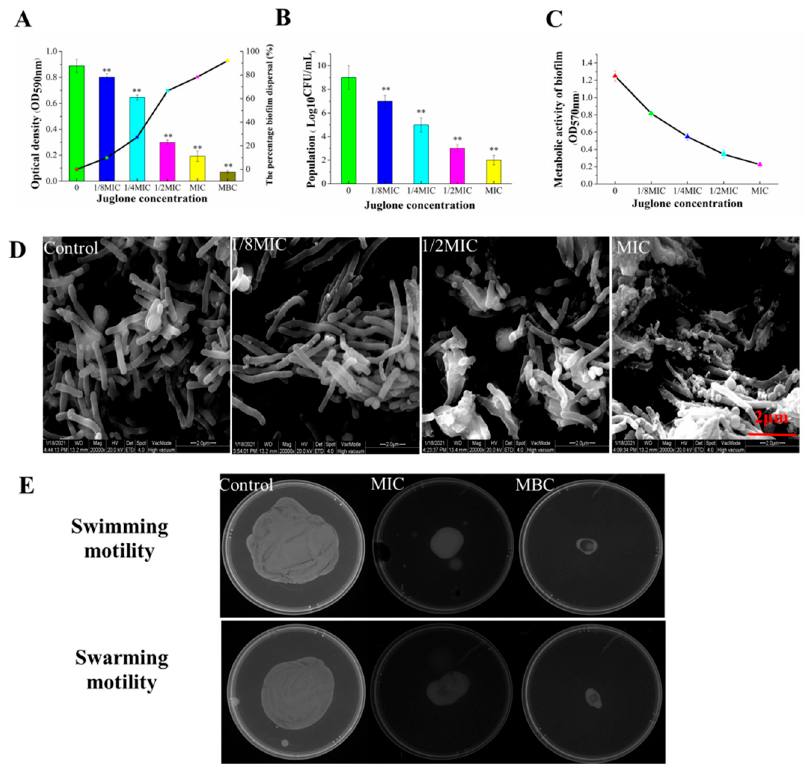
Figure 7. Inhibitory effect of juglone on the biofilm formation of P. aeruginosa . Crystal violet quantitative analysis ( A ), viability determination ( B ), cell viability determination ( C ), ESEM image analysis ( D ) and swimming and swarming motility effect of P. aeruginosa treated with juglone ( E ). Each bar represents the mean ± SD of three independent experiments; ** p < 0.01 versus the control group.